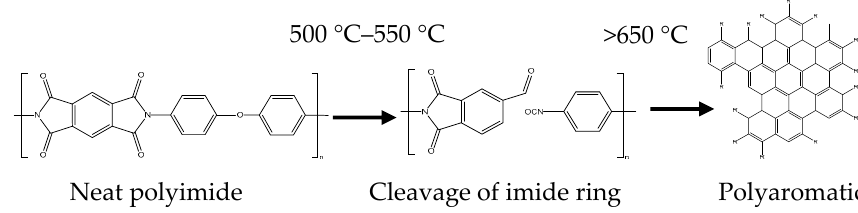
Figure 5. Degradation mechanism of polyimide in nitrogen.